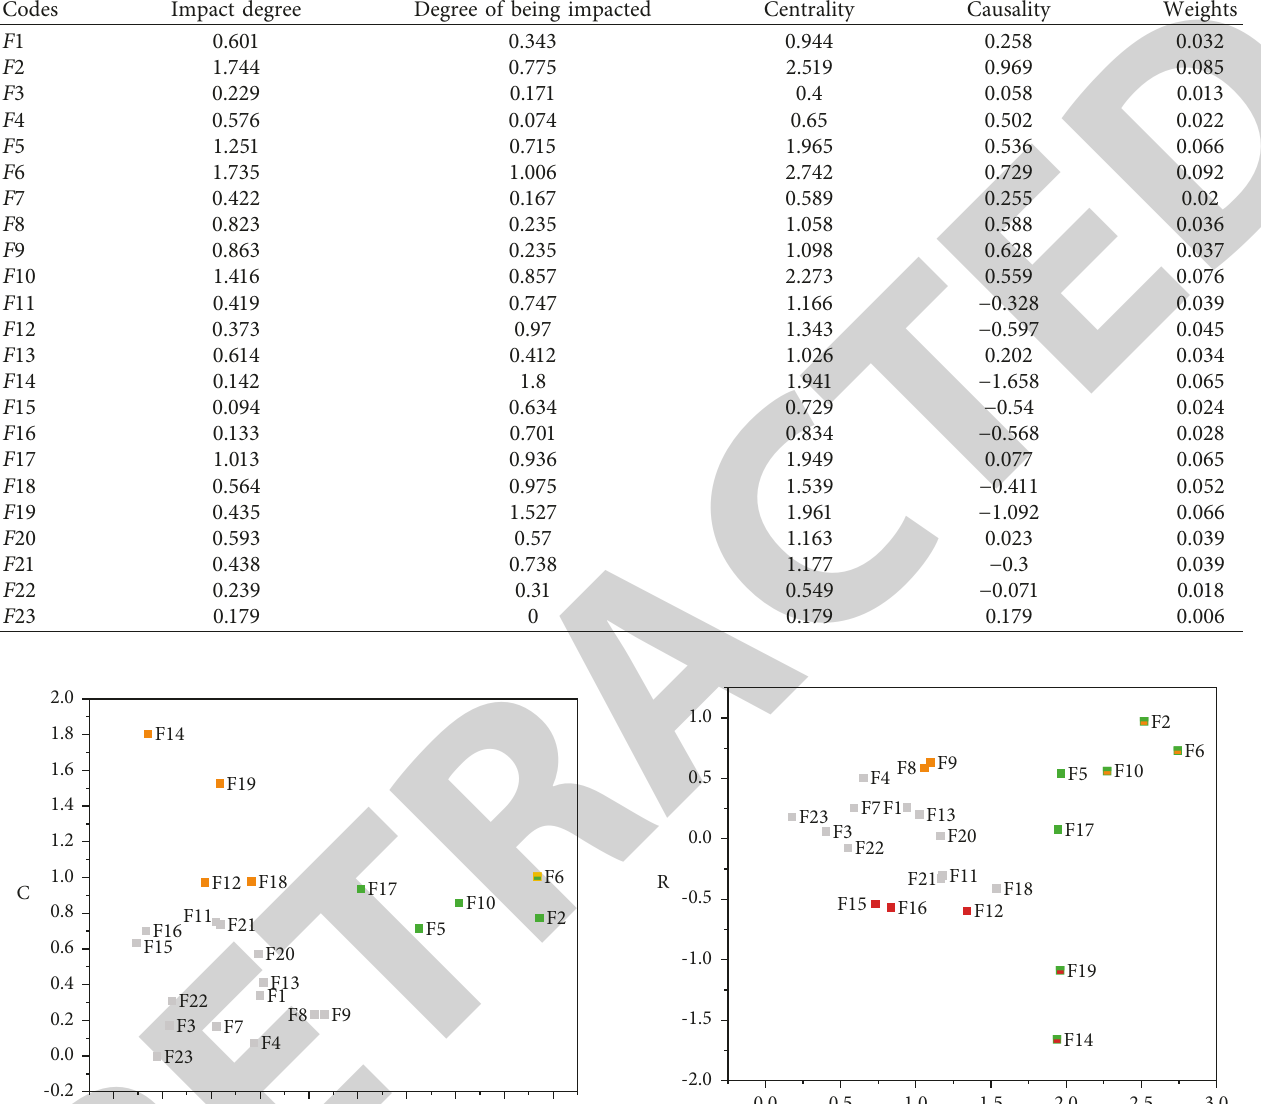
Table 3: Impact degree, degree of being impacted, centrality degree, causality degree, and weights. Codes